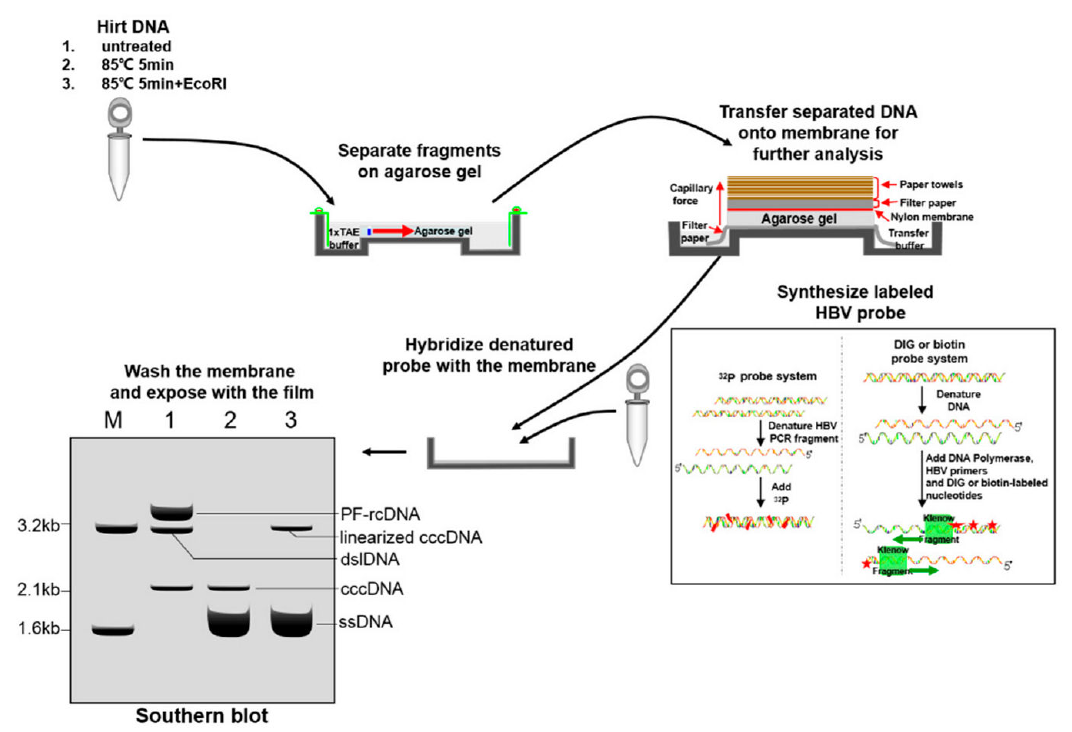
Figure 4. Detection of HBV cccDNA by a Southern blot assay in HepAD38. The typical pattern of protein-free Hirt DNA is shown after gel electrophoresis, transmembrane, hybridization and detection. M is an HBV DNA marker composed of 1.6 kb and 3.2 kb HBV fragments. The untreated extract (lane 1) contains all types of extrachromosomal protein-free DNA: PF-rcDNA, dslDNA and cccDNA. After 5 min 85 ◦ C treatment before gel loading, PF-rcDNA and dslDNA turn into ssDNA and only cccDNA remains undenatured and immobile (lane 2). When it is further digested with EcoRI, cccDNA is linearized to dslDNA (lane